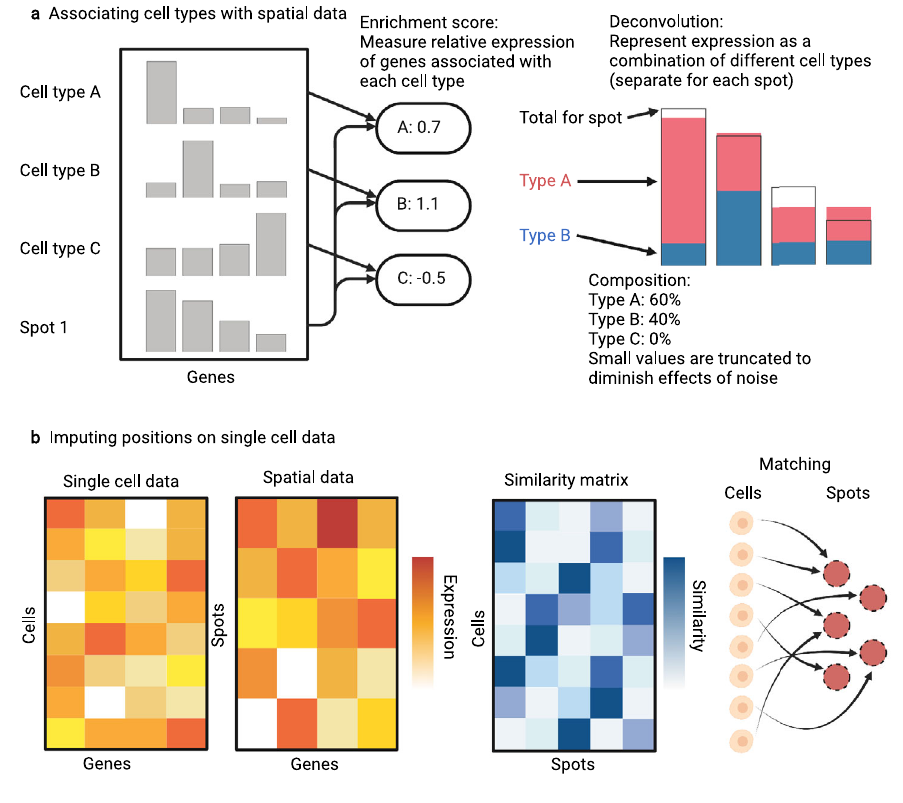
Fig. 4 Enhancing spatial transcriptomics data with scRNA-seq data. This analysis step augments ST data using scRNA-seq data. a By using scRNA-seq data onto the spatial dataset, the composition of individual spots can be understood in terms of single cells, such as by computing enrichment scores, which measure the expression of certain gene sets (such as marker genes from a particular cell type) relative to the norm, or through deconvolution, which decomposes the overall expression data from a spatial spot into a combination of contributions from several cell types. b scRNA-seq data can be used to increase resolution of multi-cell ST data, by mapping cells to spatial locations, producing a spatial dataset at single-cell resolution. The primary choices in such methods are the computation of similarity scores between cells and spots, and the method by which matching is computed from the similarity